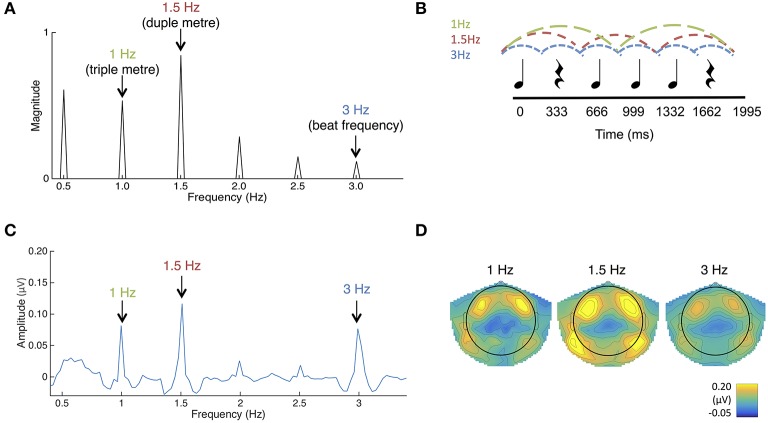
(A) The frequency spectrum of the stimulus sound envelope. (B) The rhythmic pattern, which consisted of 333 ms long tones and rests. Each tone consisted of 990 Hz pure tones with 10 ms rise and fall times. (C) Average SS-EPs with noise subtracted amplitudes averaged across all channels. Peaks can be visualized at the triple meter frequency (1 Hz), duple meter frequency (1.5 Hz), and beat frequency (3 Hz). (D) Average topographical map of the SS-EPs elicited at the triple meter frequency (1 Hz), duple meter frequency (1.5 Hz), and beat frequency (3 Hz), averaged across all participants.